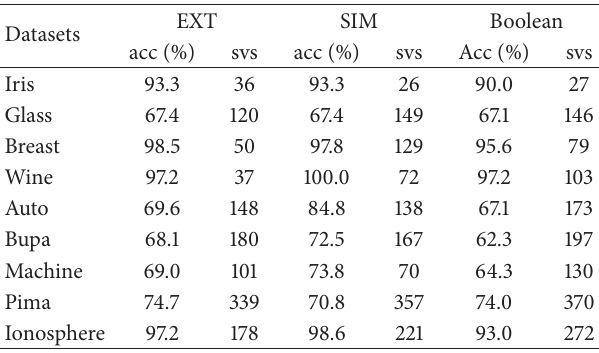
Table 4: Comparison of SVM (1-V-1) performance on 9 UCI real